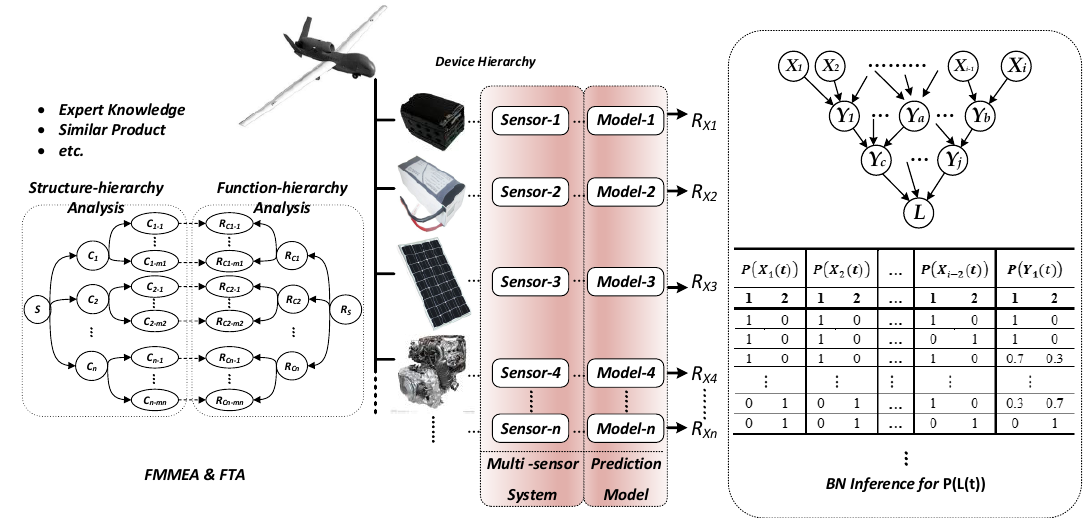
Figure 3. Modeling process of BN prediction at system level based on integrated multi-sensor information.